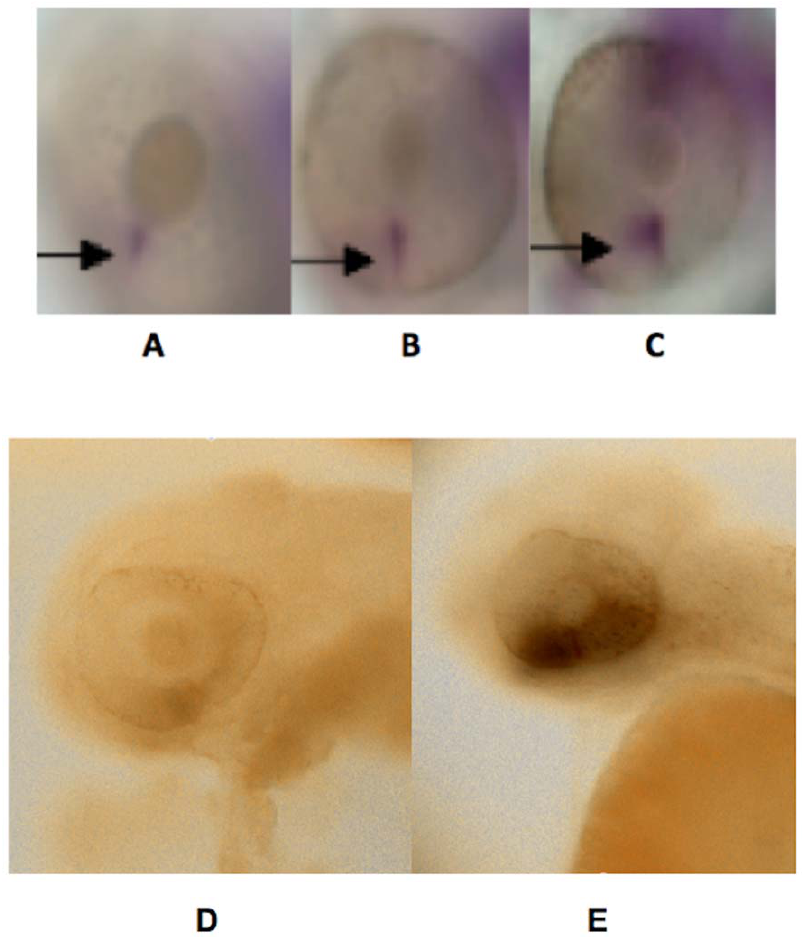
Figure 10. Pax2 and Vax2 expression are dysregulated in the region of the choroid fissure in MO1 injected morphant larvae. Fig. 10. Fig. 10A–C. Representative, uninjected (Fig. 10A), control morpholino injected (Fig. 10B) and MO1 morpholino injected (Fig. 10C) whole embryos hybridized with a Pax2 probe. The region of Pax2 labeling at the site of the choroid fissure (indicated by arrows) is enlarged in the MO1 morphant embryo compared to both the uninjected and control-injected embryos. Fig. 10D. Representative control morpholino injected (Fig. 10D–E) and splice morpholino (MO3) injected (Fig. 10E) whole embryos hybridized with a Vax2 probe. The region of Vax2 labeling (indicated by arrows) is enlarged in the MO3 morphant embryo compared to the control-injected